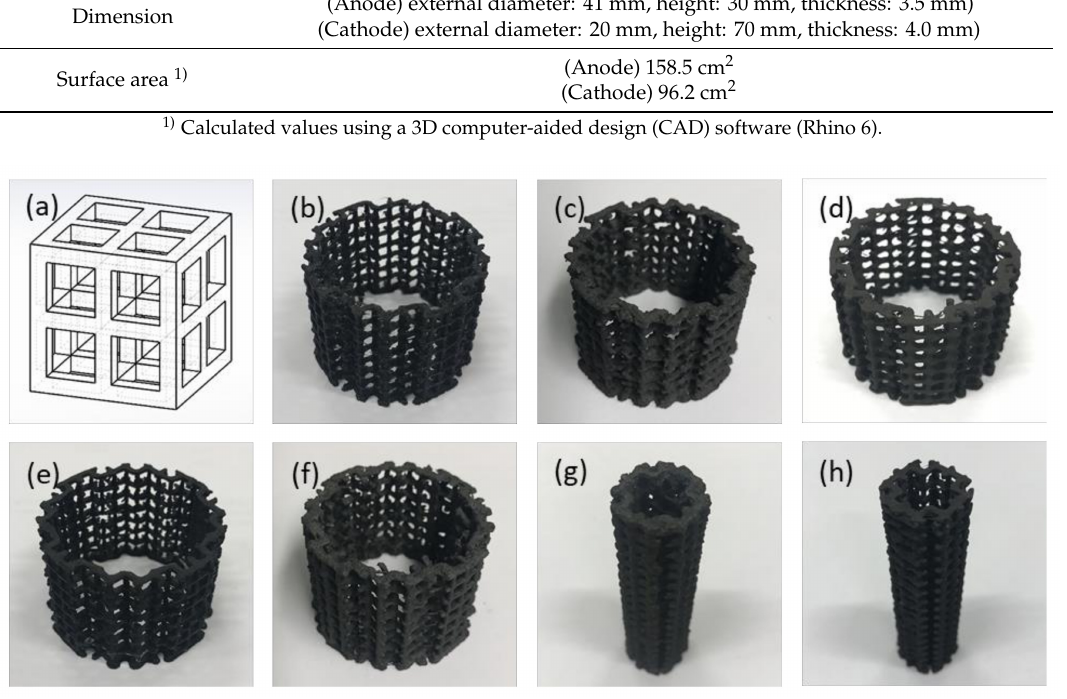
Figure 6. 3D CAD design of the unit structure and test electrodes: ( a ) 3D CAD image of the electrode unit structure; ( b ) PLA anode; ( c ) C-PLA anode; ( d ) Ni-PLA anode; ( e ) cPLA anode; ( f ) C-cPLA anode; ( g ) C-PLA cathode; and ( h ) Ni-PLA